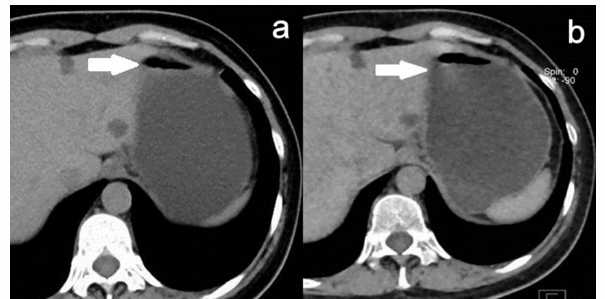
Figure 5. More obvious overshooting artifact at the gas-fluid level (arrow) was detected in VNE image. a. TNE image; b. VNE image.